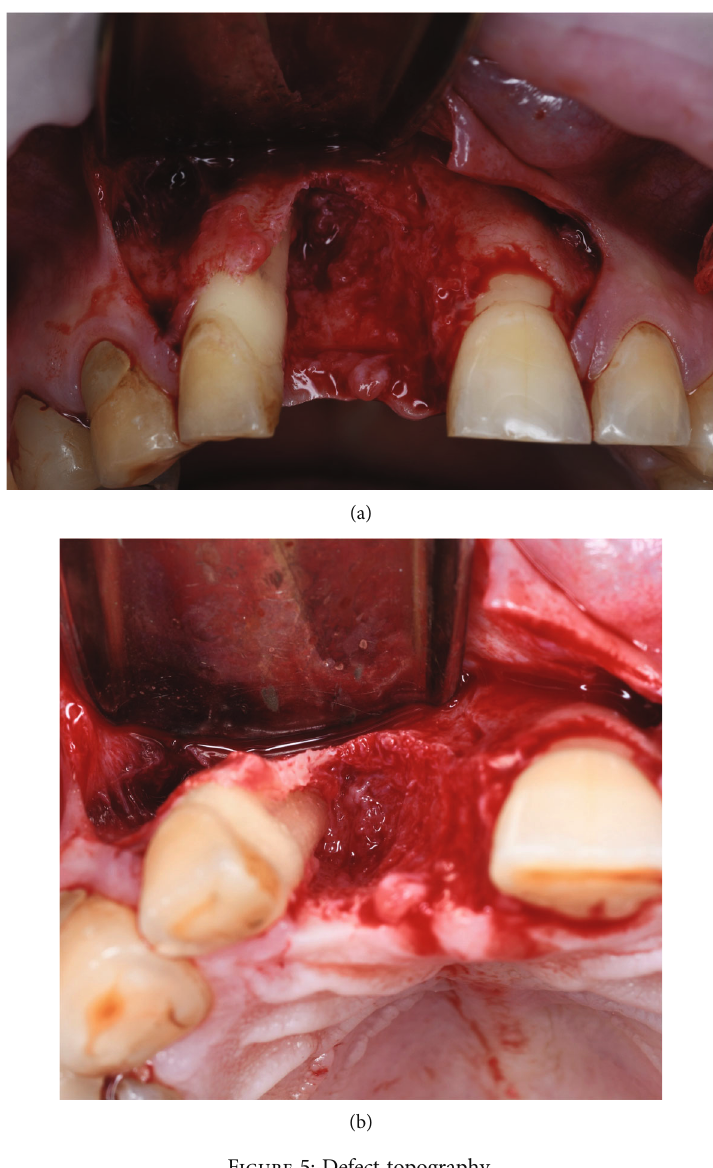
Figure 5: Defect